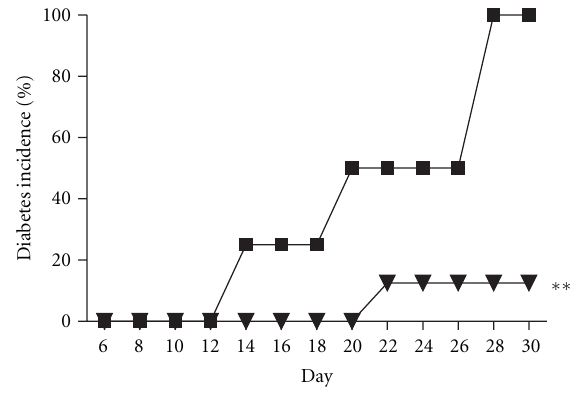
Figure 1: Mice deficient in CD73 are resistant to MLDS-induced diabetes. Diabetes incidence in C57BL/6 wild-type (WT) mice (black squares, n = 4) and CD73KO (black triangles, n = 8) mice following MLDS. ∗∗ P < 0 . 01 versus WT